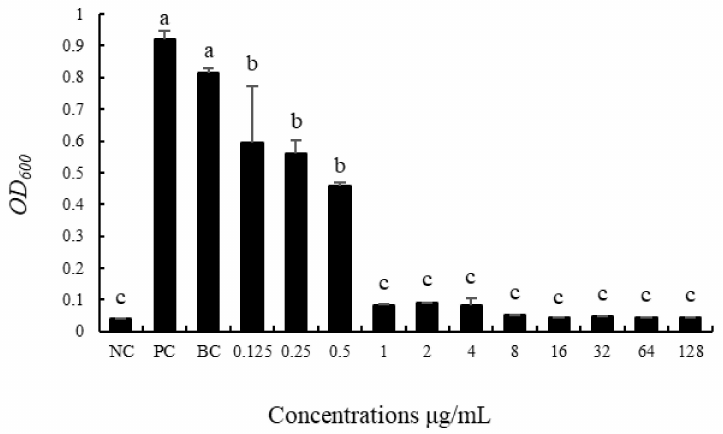
Figure 2. Antibacterial effects of different concentrations of ciprofloxacin on cultivable gut microbiota of Grapholita molesta . NC: negative control; PC: positive control; BC: blank control. The different lowercase letters indicate significant differences among different treatments (one-way ANOVA, Tukey post-hoc test, p <